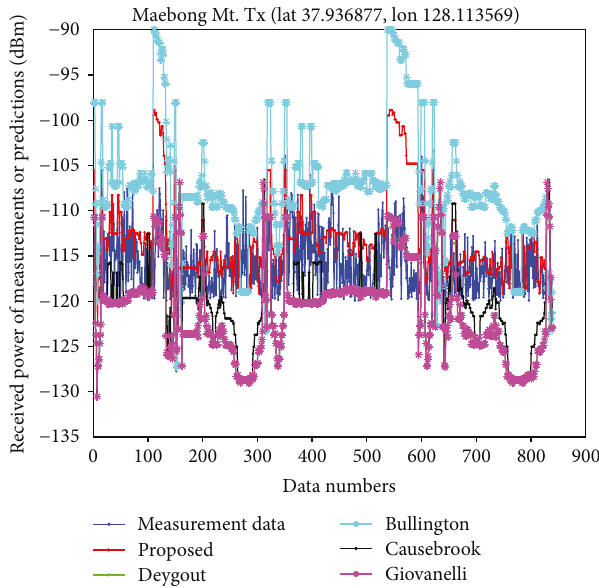
Figure 15: Comparison of the measurements and predictions in the west side of Mt. Maebong.